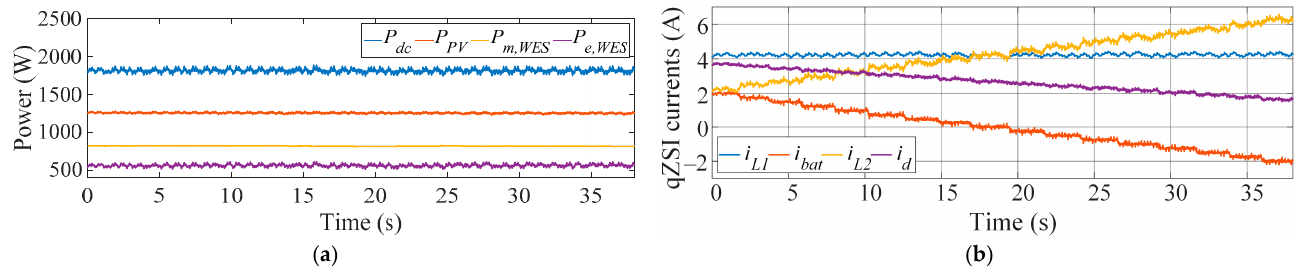
Figure 20. Dynamic responses to changes in the battery current reference: ( a ) electrical power and WT mechanical power, and ( b ) qZSI currents. WT mechanical power, and ( b ) qZSI